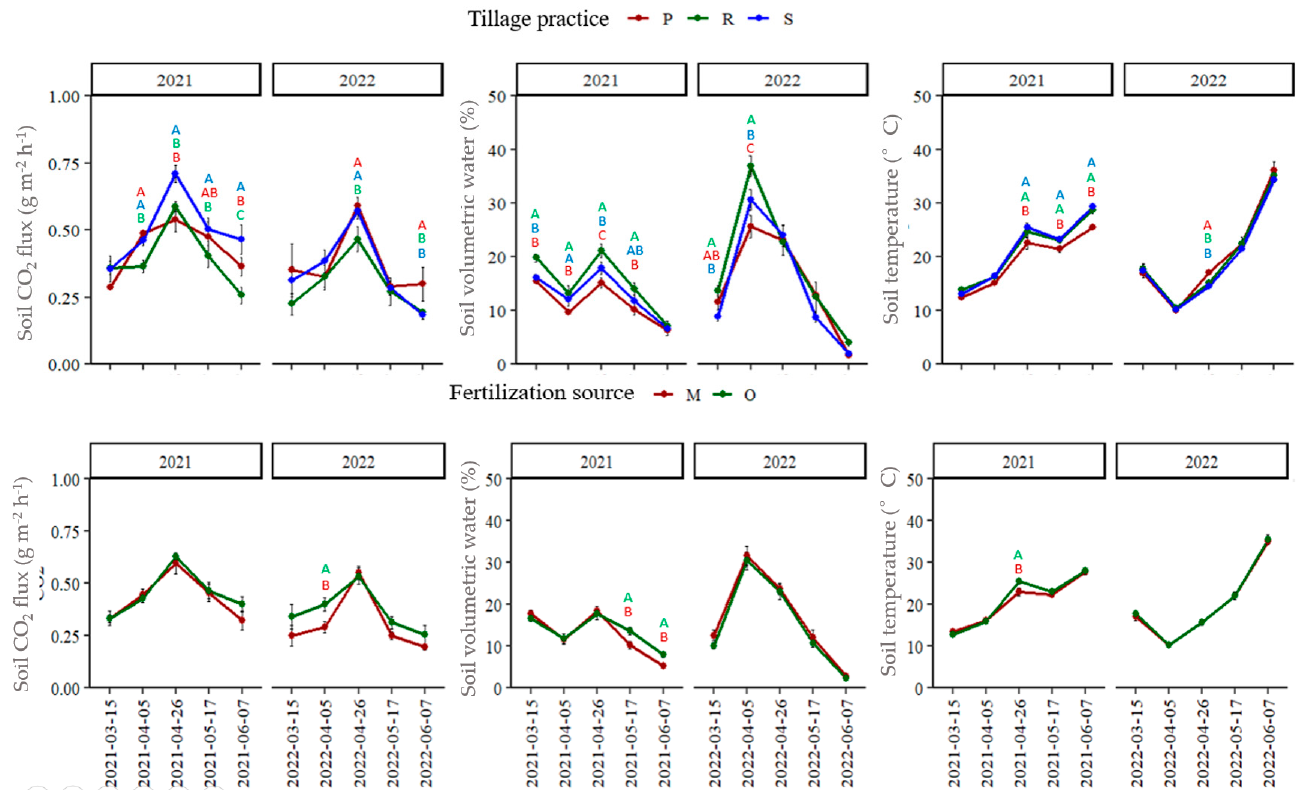
Figure 3. Soil CO 2 emissions, soil temperature, and soil volumetric water content under the three soil tillage practices: plowing (P), subsoiling (R) and spading (S), and under inorganic (M), organic (O) fertilization sources during 2021 and 2022 durum wheat growing seasons. Bars represent standard error. No letters mean that differences between the means were not significant ( p > 0.05).